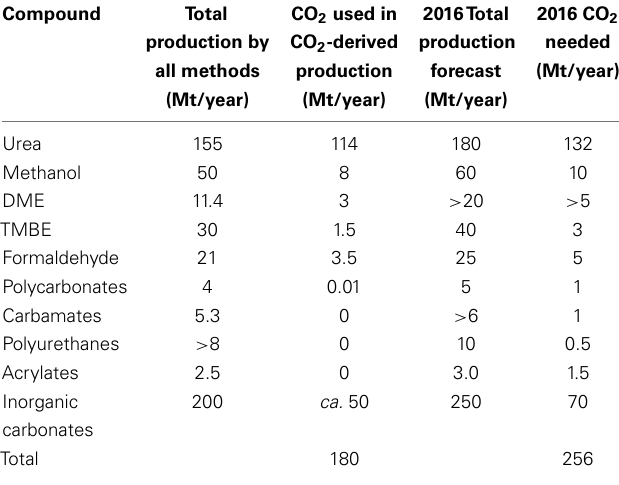
Table 2 | Current CO 2 utilization technologies and forecasts for 2016 [adapted fromAresta et al. (2013)] .